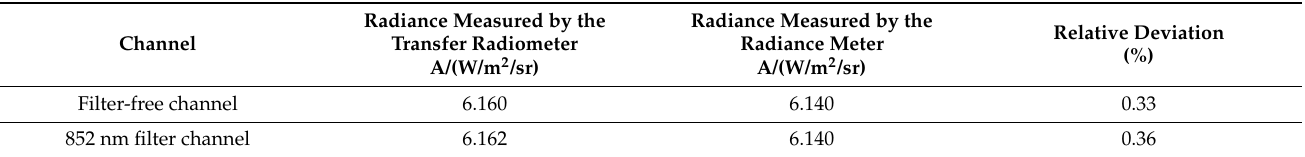
Table 5. Relative deviations of measurements from the transfer radiometer and the radiance meter at a wavelength of 852.1